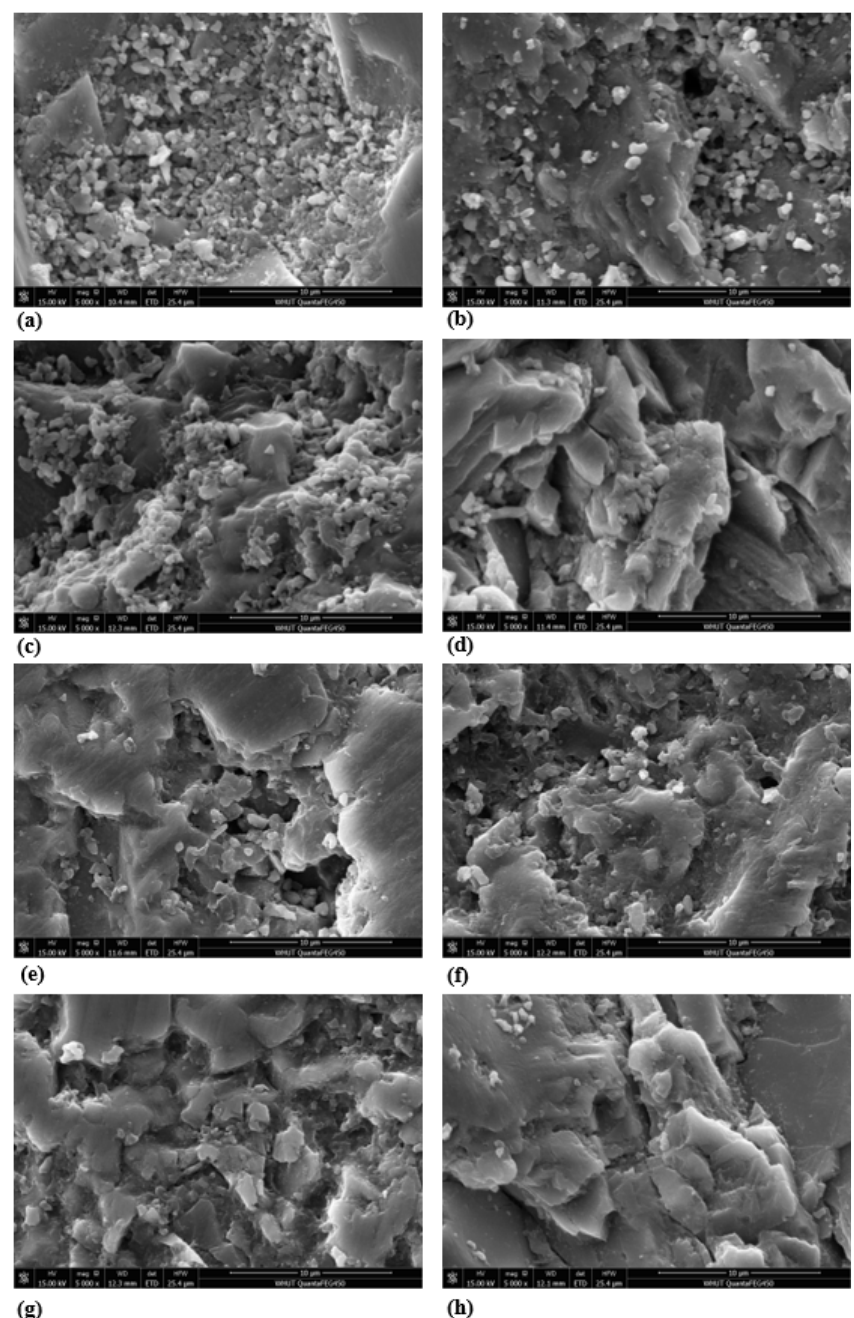
Figure 8. SEM (SE mode) surface microstructure of various samples, ( a ) 1 M H 2 SO 4 , ( b ) 2.5 M H 2 SO 4 , ( c ) 4.5 M H 2 SO 4, ( d ) 5 M H 2 SO 4 , ( e ) 1 M HCl, ( f ) 2.5 M HCl, ( g ) 4.5 M HCl, ( h ) 5 M